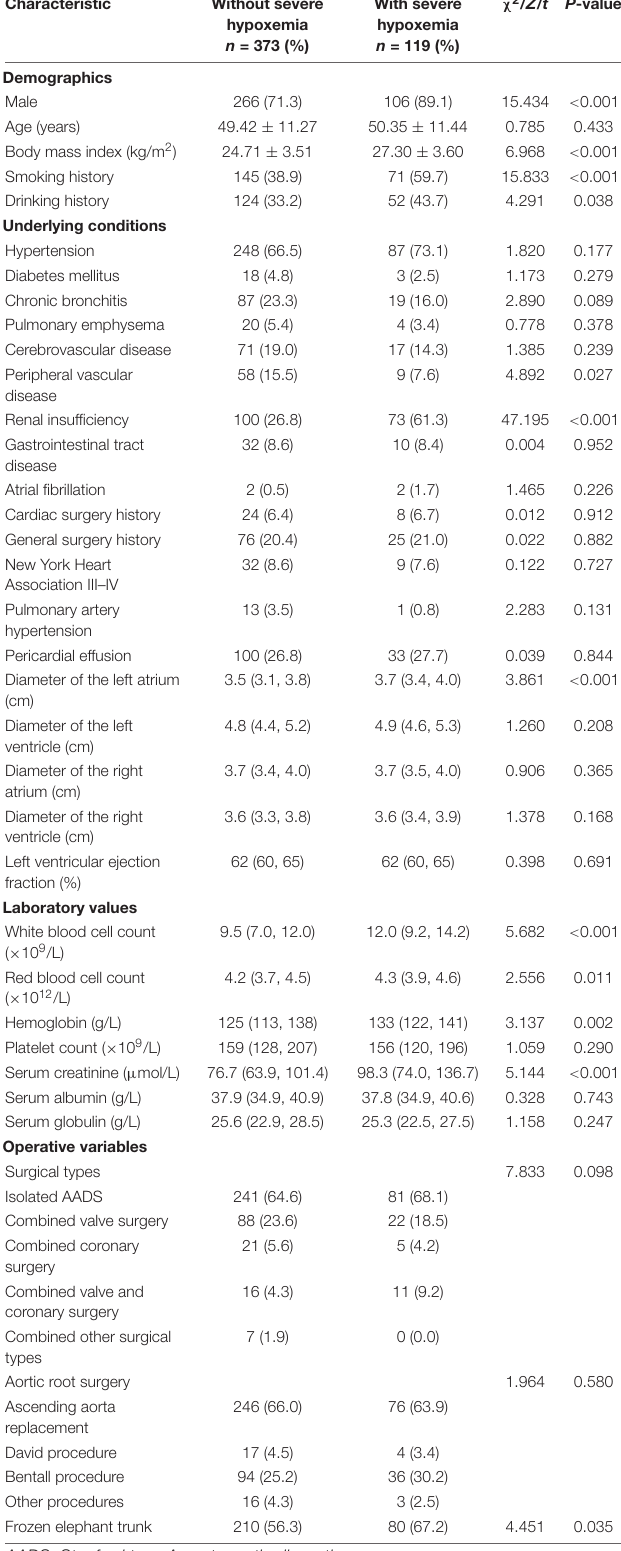
TABLE 1 | Univariate analysis of possible risk factors for severe hypoxemia after AADS. Characteristic Without severe